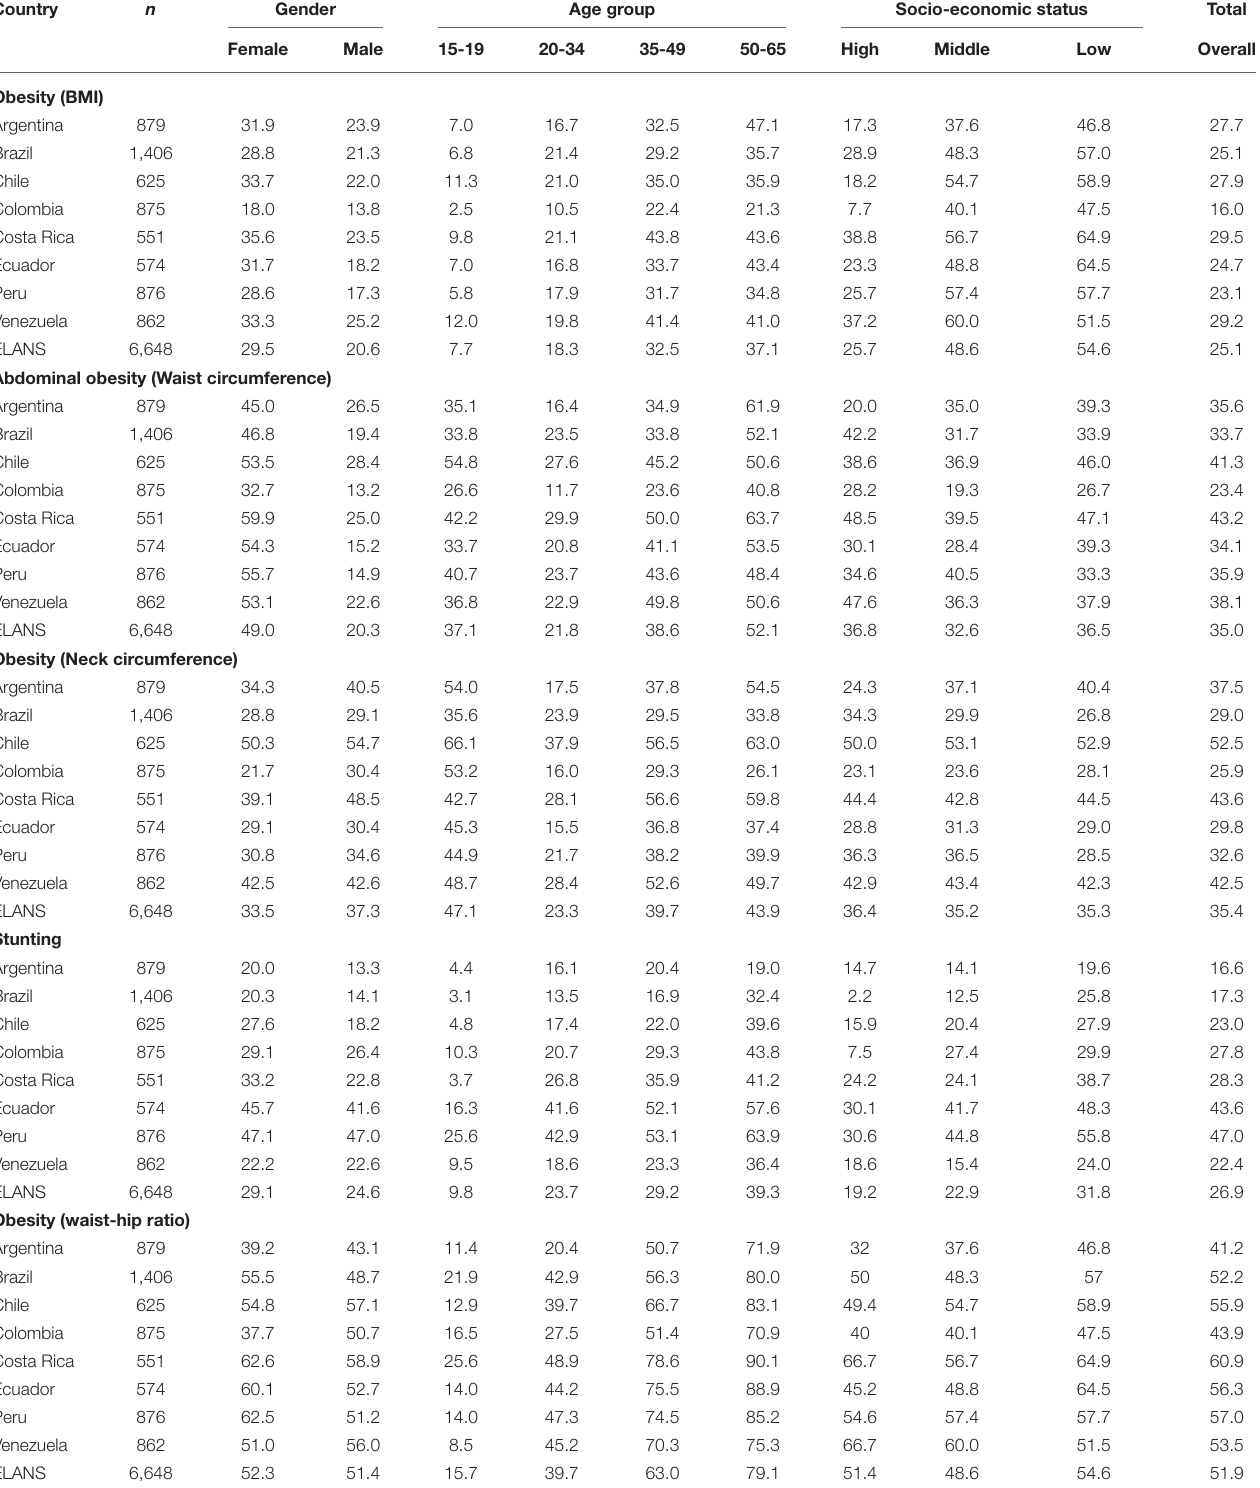
TABLE 1 | Comparison of the anthropometric indicators prevalence according to the country of living, gender, age group, and socioeconomic status in the Latin American Study of Nutrition and Health (ELANS) * . Country n Gender Age group Socio-economic status Total Female Male 15-19 High Middle Low Overall